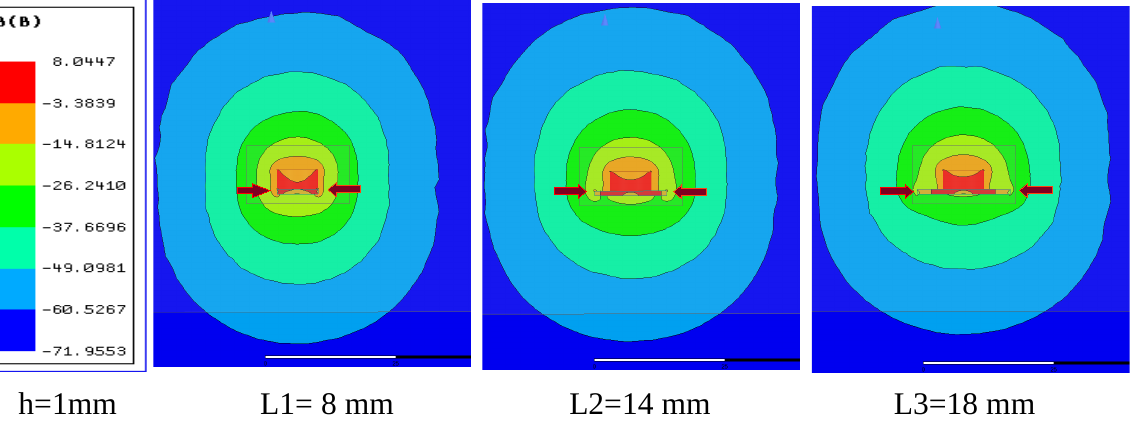
Figure 6. MO vs. increasing reactive part length: L1 = 8 mm, L2 = 14 mm, and L3 = 18 mm, with a constant thickness value equal to 1